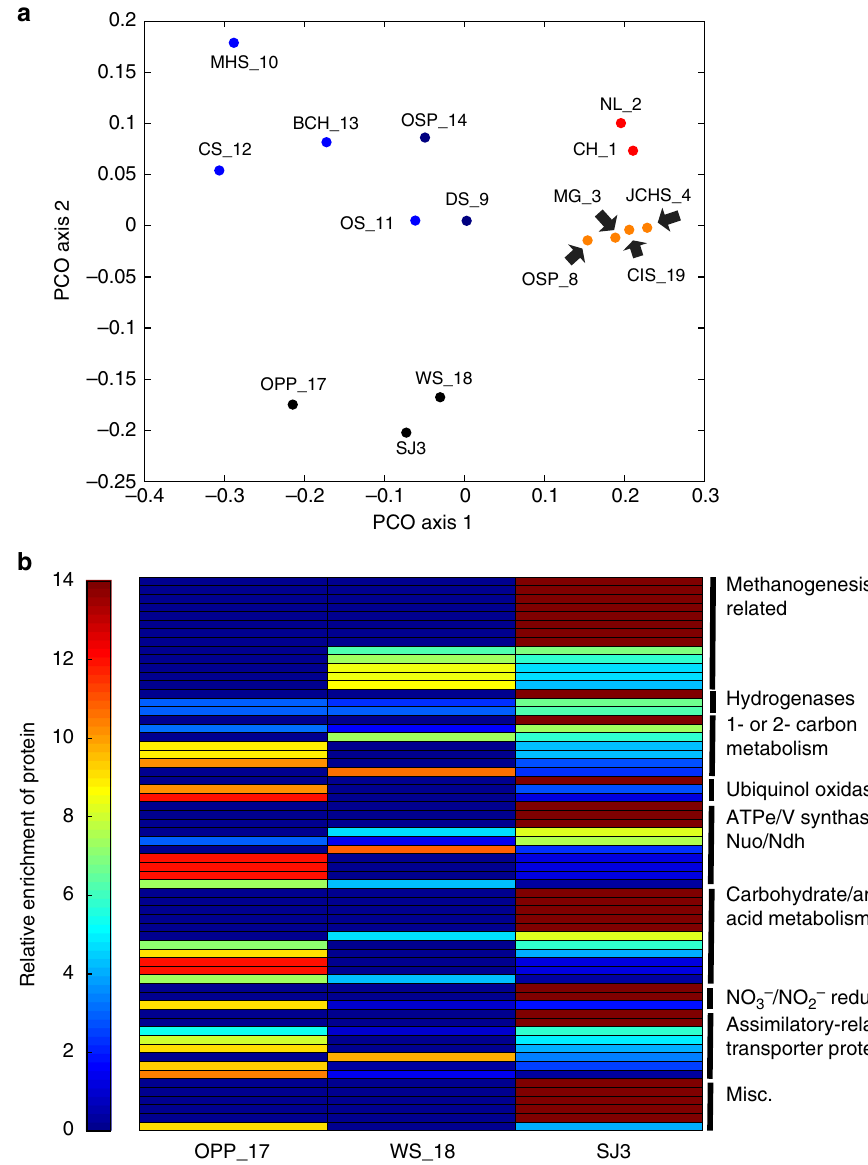
Fig. 6 Similarity in proteins putatively involved in energy metabolism among SJ3 and 14 other published YNP metagenomes. a Principal coordinates analysis (PCO) shows the similarity in proteins that are putatively involved in energy metabolism pathways among metagenomes, where each point represents a metagenome. Points are colored based on taxonomic and geochemical differences: light blue, high pH Aqui fi cales-dominated communities (pH 6.5 – 7.9); dark blue, low pH Aqui fi cales-dominated communities (pH 3.1 – 3.5); red, low pH Sulfolobales-dominated communities (pH 2.6 – 4); orange, low-mid pH Crenarchaeaota-dominated communities (pH 3.4 – 6.4); black, mid pH Crenarchaeota/Aqui fi cales/uncultured bacterial division dominated communities (pH 5.4 – 6.4). b Heatmap showing enrichment of speci fi c proteins putatively involved in the energy metabolism in the SJ3 community